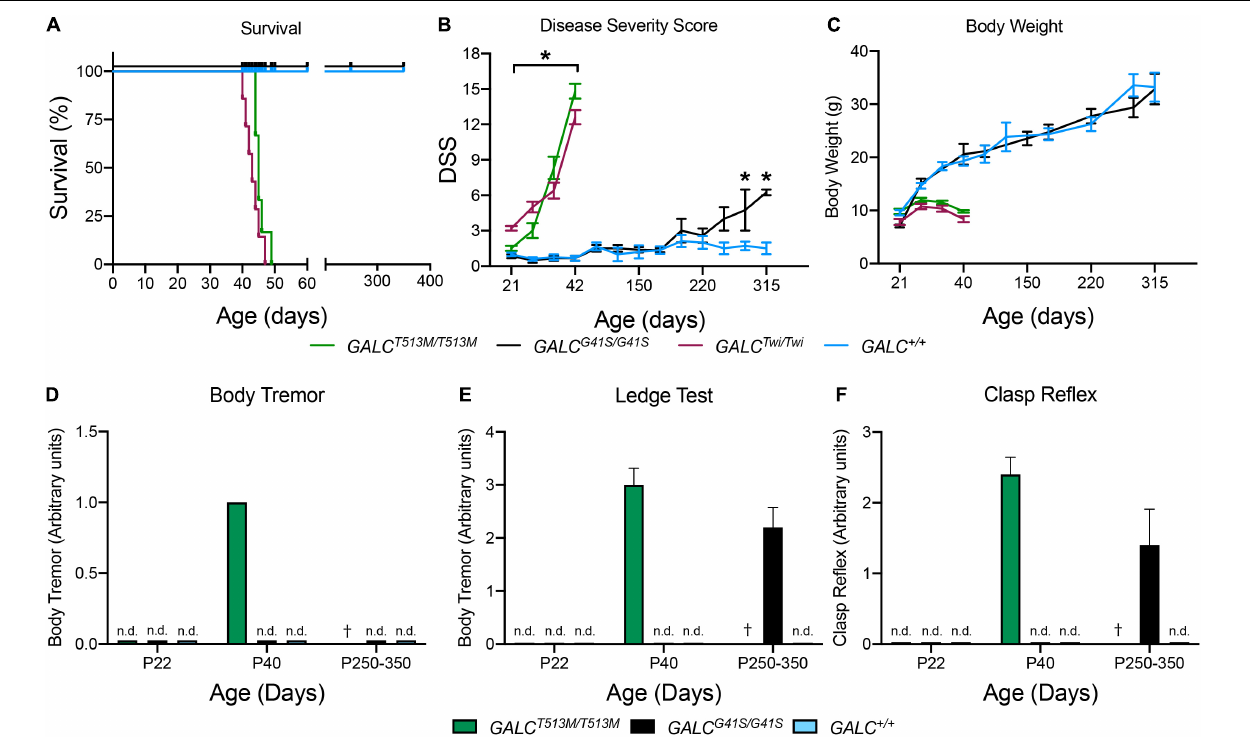
FIGURE 3 | Clinical analysis of GALC T 513 M / T 513 M and GALC G 41 S / G 41 S mice. Survival (A) , disease severity score (DSS) (B) , body weight (C) , onset of body tremor (D) , onset of errors on the ledge test (E) , and onset of affected clasp reflex (F) were measured for each genotype. n.d., non-detected; † , dead. n = 6–8 mice/genotype/time point. * p < 0.05.